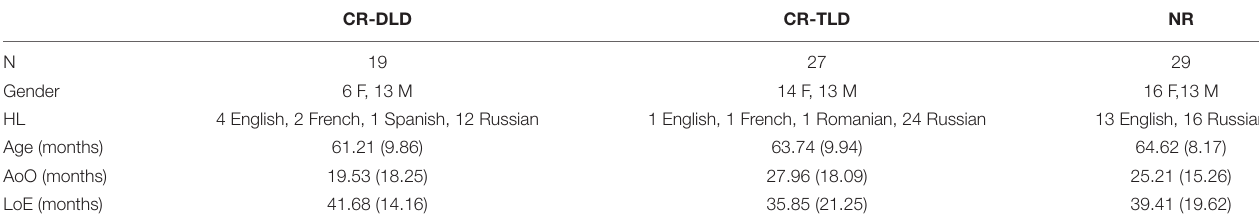
TABLE 1 | Demographic data of the three